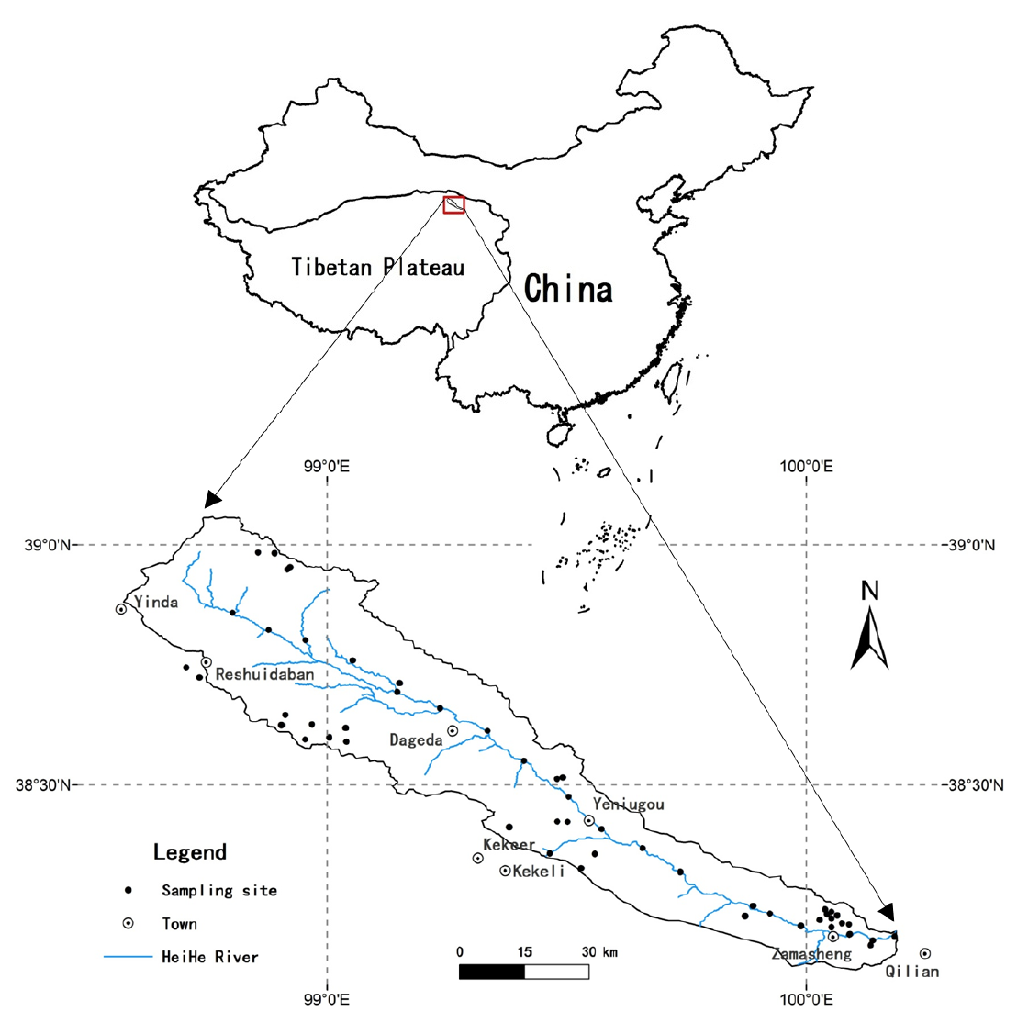
Figure 1. Map of the study area and surface soil sampling sites.